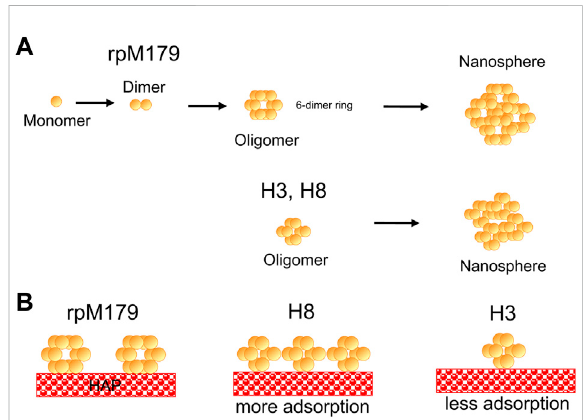
FIGURE 6 Schematic drawings of (A) the hierarchical quaternary structure of rpM179 from monomer to dimer to six-dimer oligomer ring to nanosphere as suggested by the literature (Bromleyetal.,2011;Fangetal.,2011)andfromoligomerring to nanosphere for H3 and H8 as suggested by the adsorption and DLS results of this study. Smaller oligomers are shown for H3 and H8 as indicated by the AFM and TEM results. (B) Differences in adsorption onto HAP resulting in higher adsorption amounts for H8, and lower adsorption amounts for H3 compared to rpM179. The oligomer rings are oriented perpendicular to the surface for clarity in the schematic and because that orientation would promoteinteractionswiththeC-terminus.Theorientationofrings onto the HAP surface is not known at the present time,